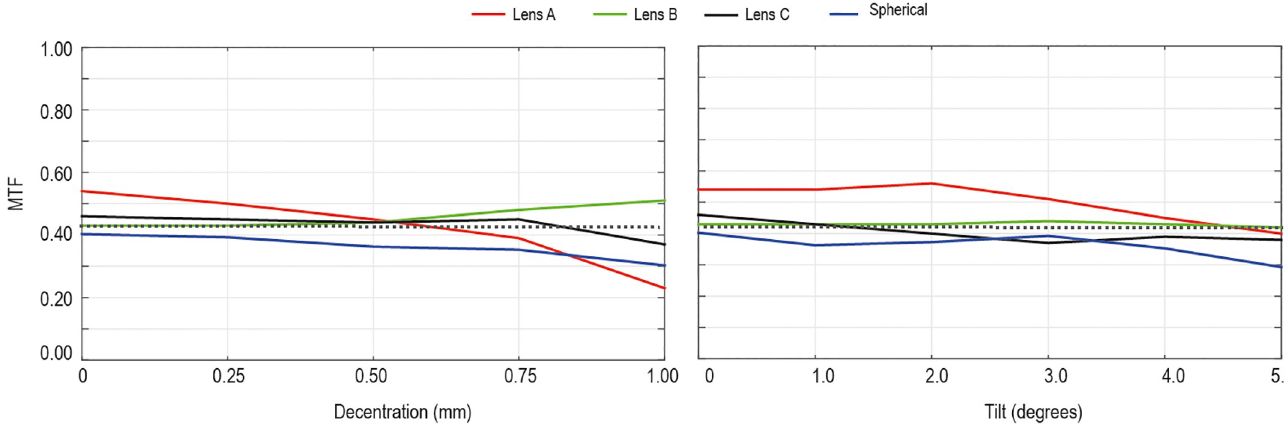
Fig 4. The experimental MTF (3.00 mm pupil diameter and 100 cycles per degree) for a refractive power of +20.00 D tested in-vitro with the PMTF optical bench as a function of: Left column: Decentration . Right column: tilt. https://doi.org/10.1371/journal.pone.0232546.g004 Fig 5 shows the experimental TF-MTF for 100 cycles per degree obtained in the PMTF for a 3.00 mm diameter pupil and 546 nm wavelength. As it can be seen, on the one hand the MTF for Lens A is higher than for Lens B, C or spherical IOLs designs. On the other hand, the other lenses have a longer depth of focus than Lens A.